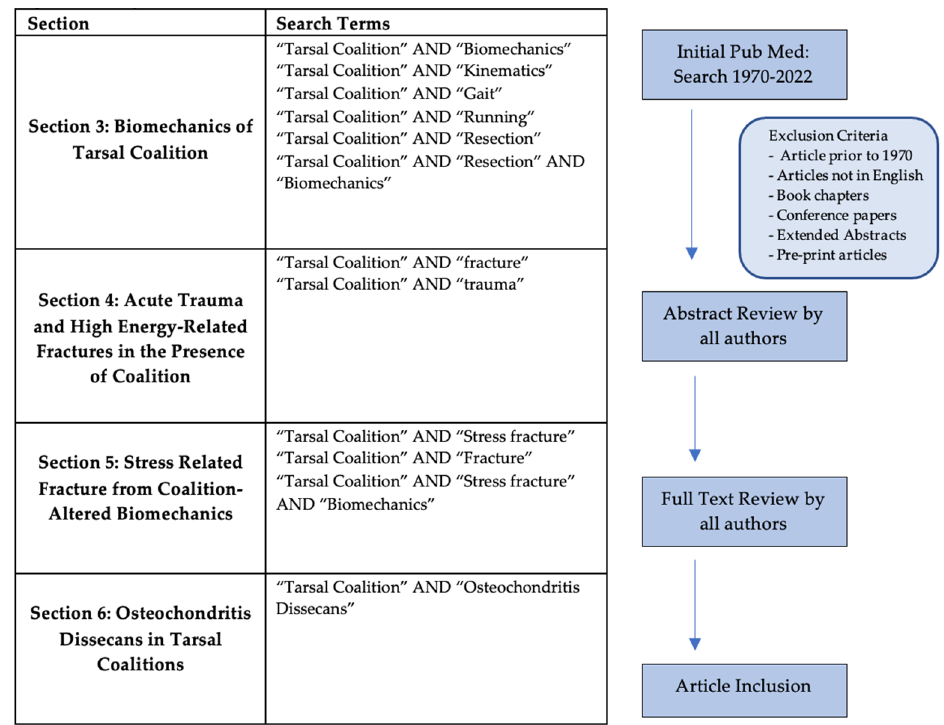
Figure 3. Study Selection and Search Criteria.